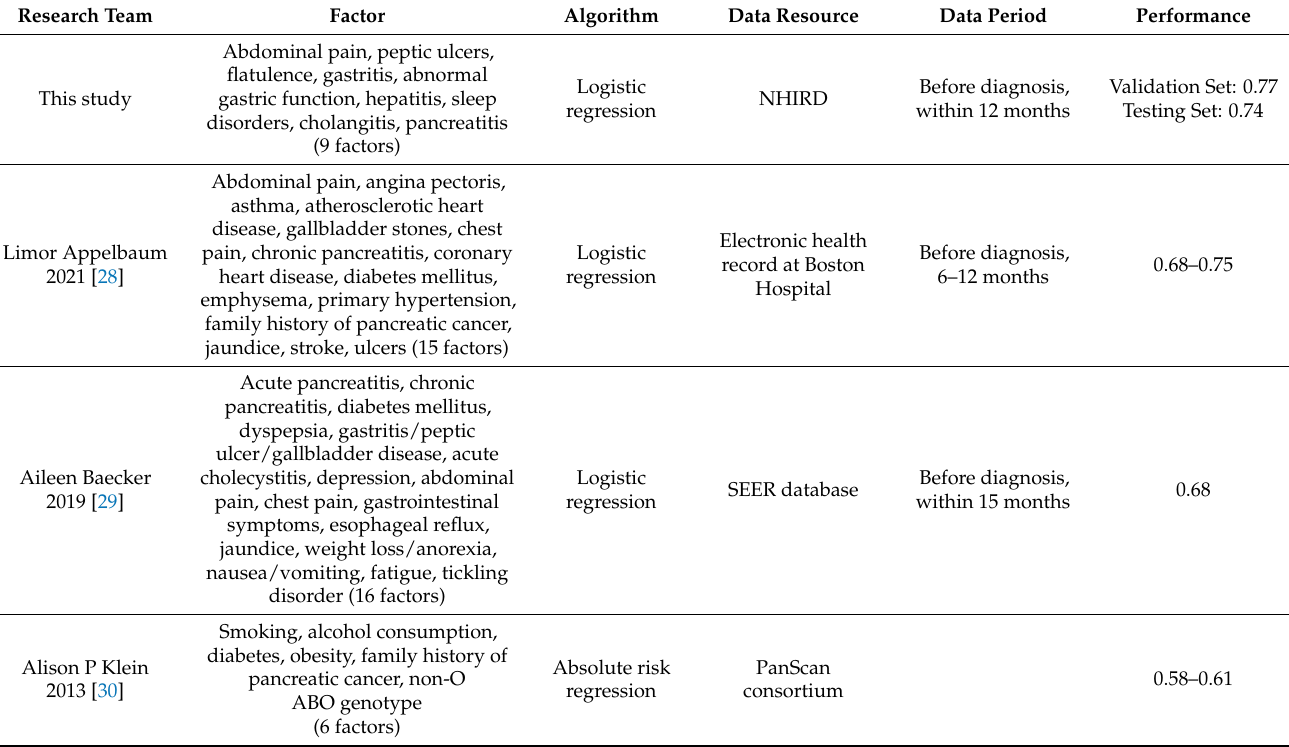
Table 4. Model comparison with previous